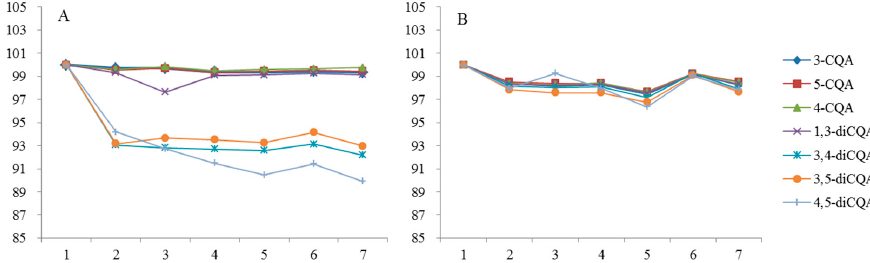
Figure 3. Thermal stability of CQAs in solution of 50% ( v / v ) aqueous methanol stored at brown bottle. ( A ) Room temperature; ( B ) 4 °C.